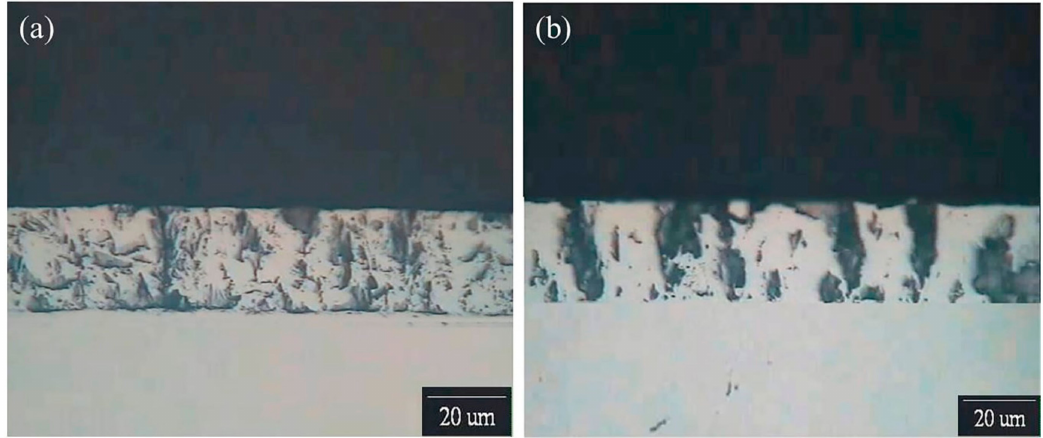
Figure 1. Cross-sectional micrographs of the ( a ) non-heated and ( b ) heat-hardened Cr–C-coated samples without an